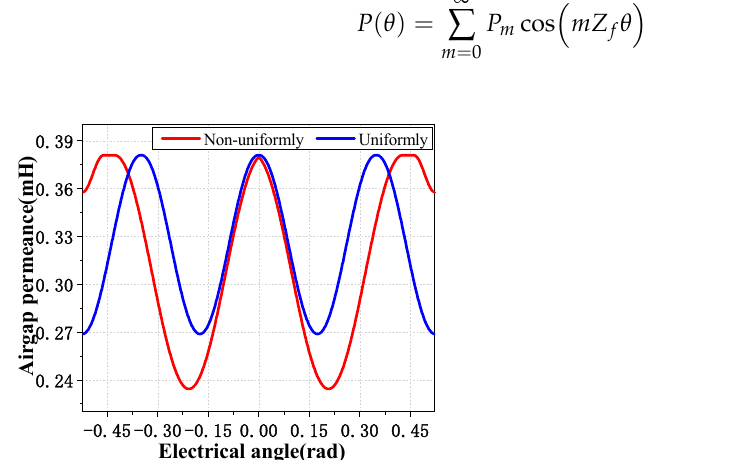
Figure 4. Analytical airgap permeance in one unit of two different tooth distribution